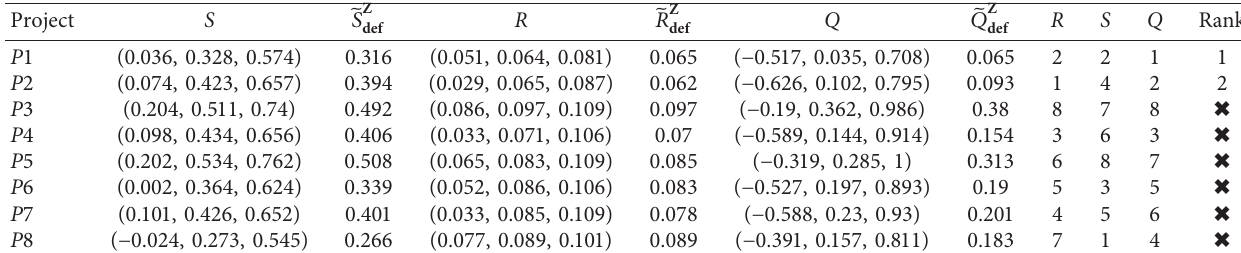
Table 45: Project ranking table (8